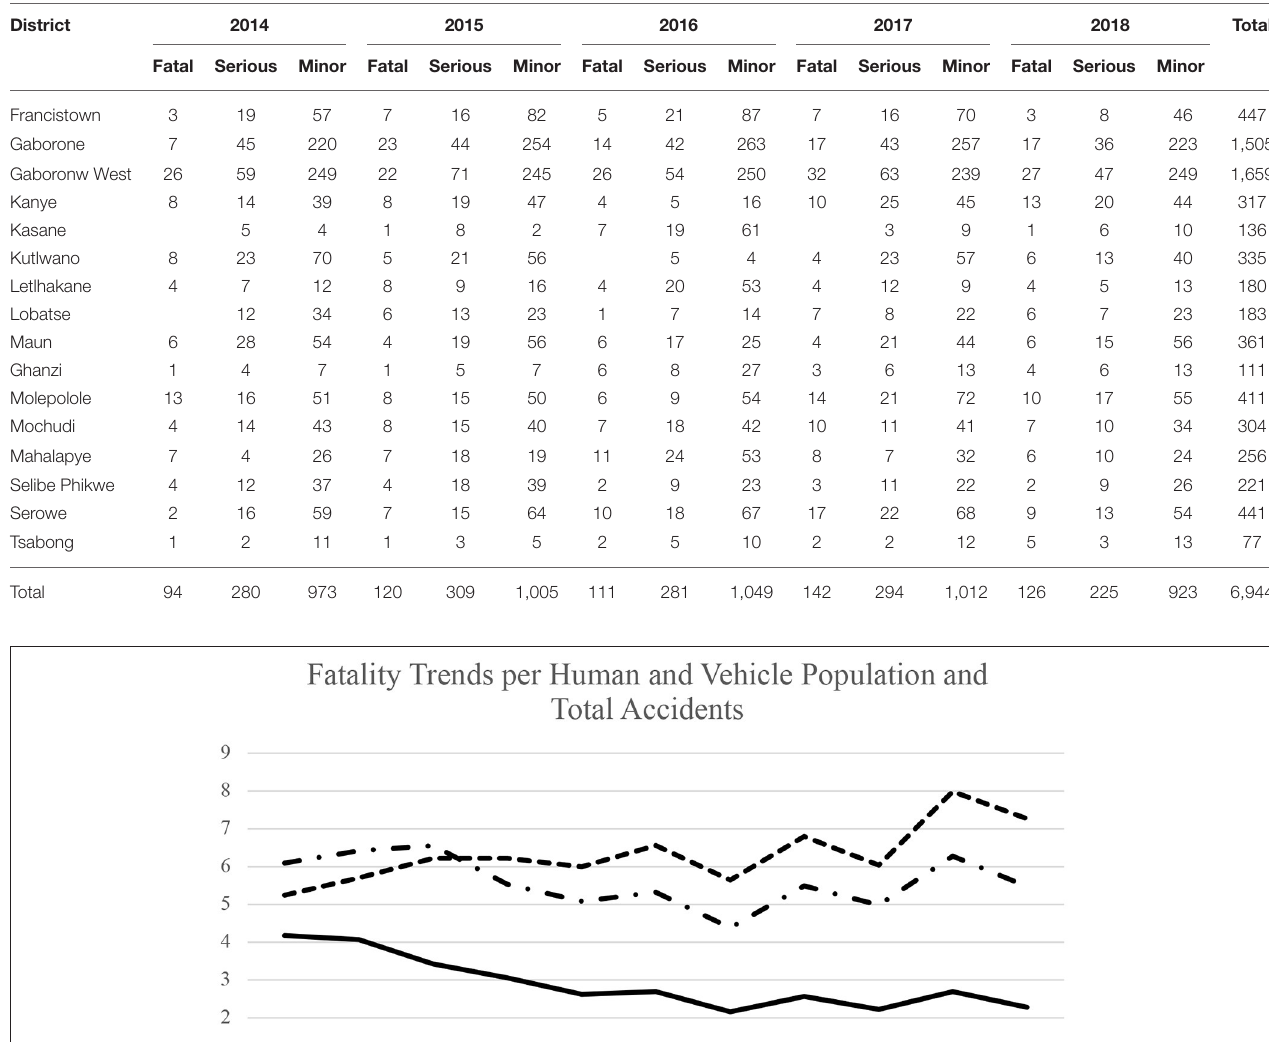
TABLE 1 | Pedestrian accident severity by police region.